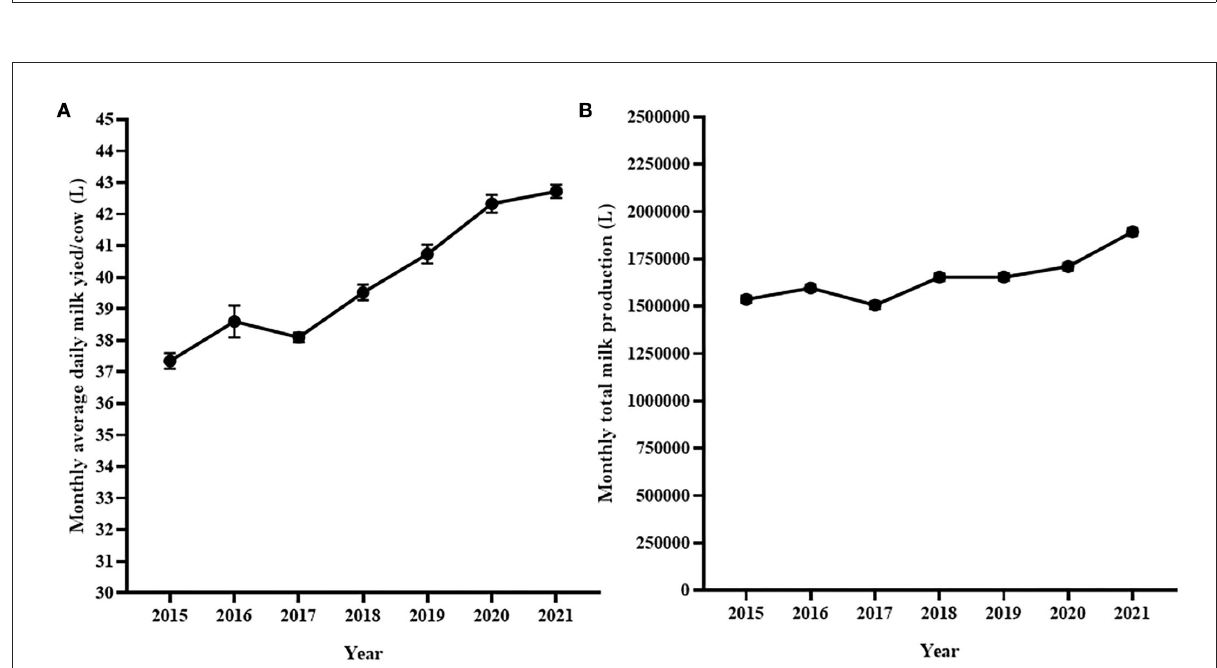
FIGURE5 Trend of monthly average daily milk production (A) and monthly average total milk production (B) for seven study years. Both monthly average daily and monthly total milk production at the National Dairy farm was gradually increasing during the study years except in 2017.